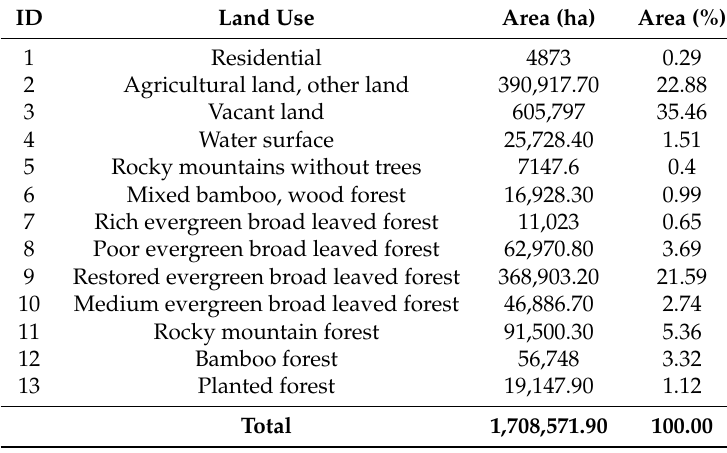
Table 1. Land use in Son La Province